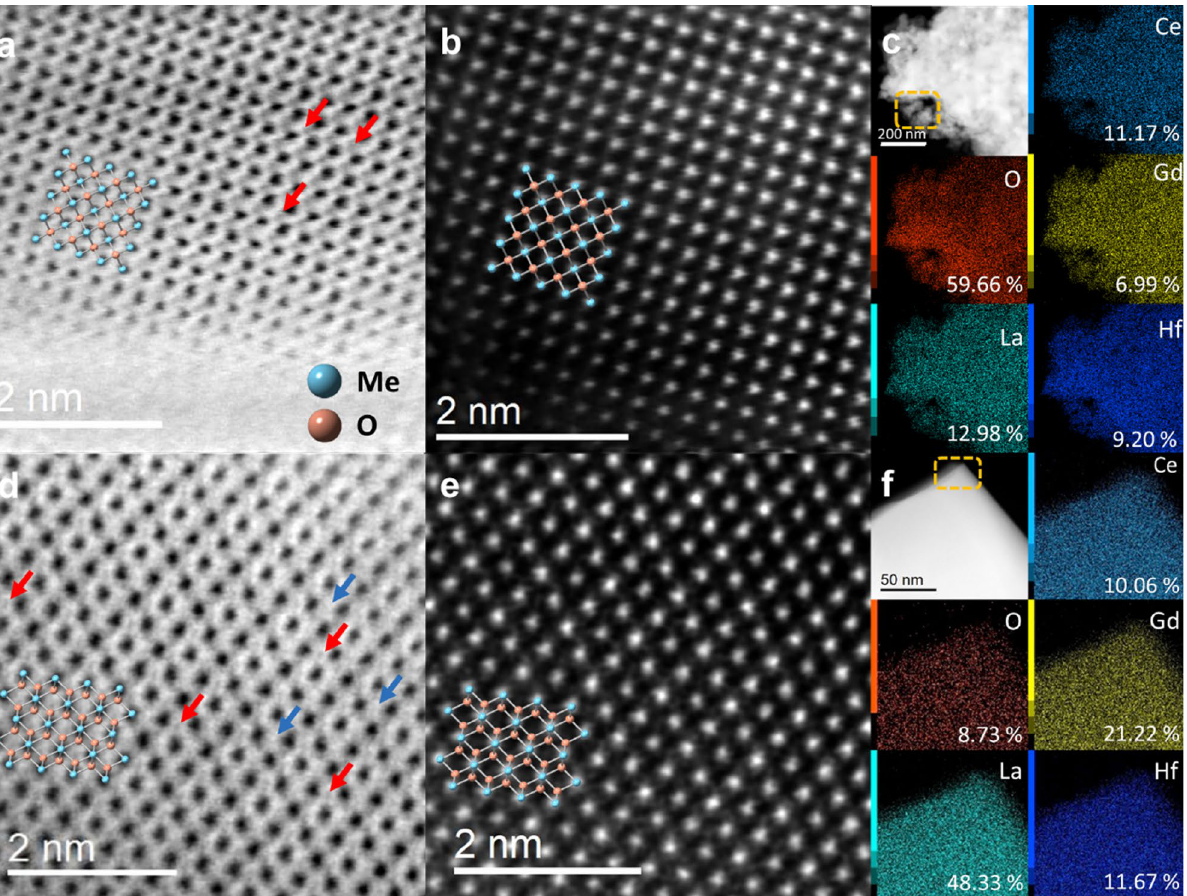
Figure 5. ABF-STEM, HADDF-STEM images and corresponding STEM-EDS results of ( a – c ) Hf-MPO-1000 along [100] direction and ( d – f ) oxygen-lack region in Hf-MPO-1500 along [110] direction. Red arrows pointed out the weak contrast of oxygen’s atomic column. Blue arrows pointed out the possible sites with a high concentration of oxygen